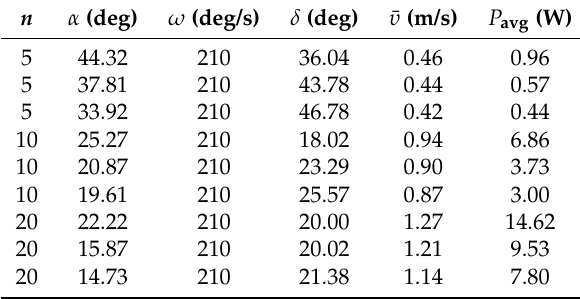
Table 7. Multi-objective optimization results for the land-based snake robot with different numbers of